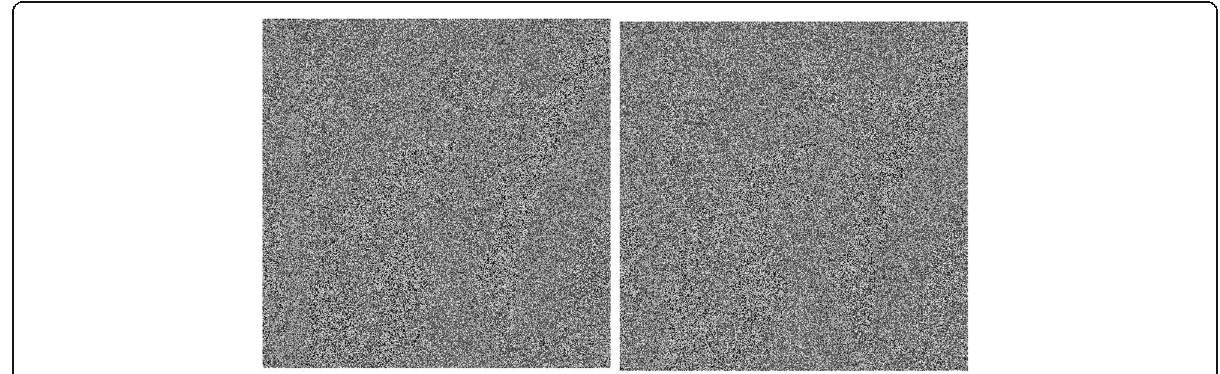
Fig. 5 The contrast of Lena ’ s ciphertext before and after the